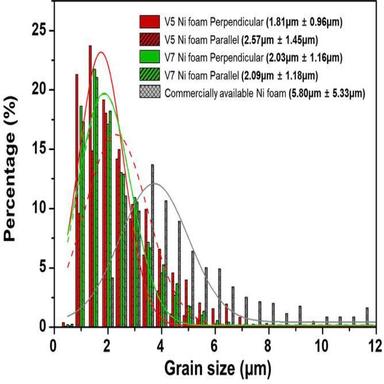
Grain size distributions of Ni foams fabricated by freeze casting from slurries containing 5 vol% and 7 vol% NiO powder, and commercially available Ni foam.